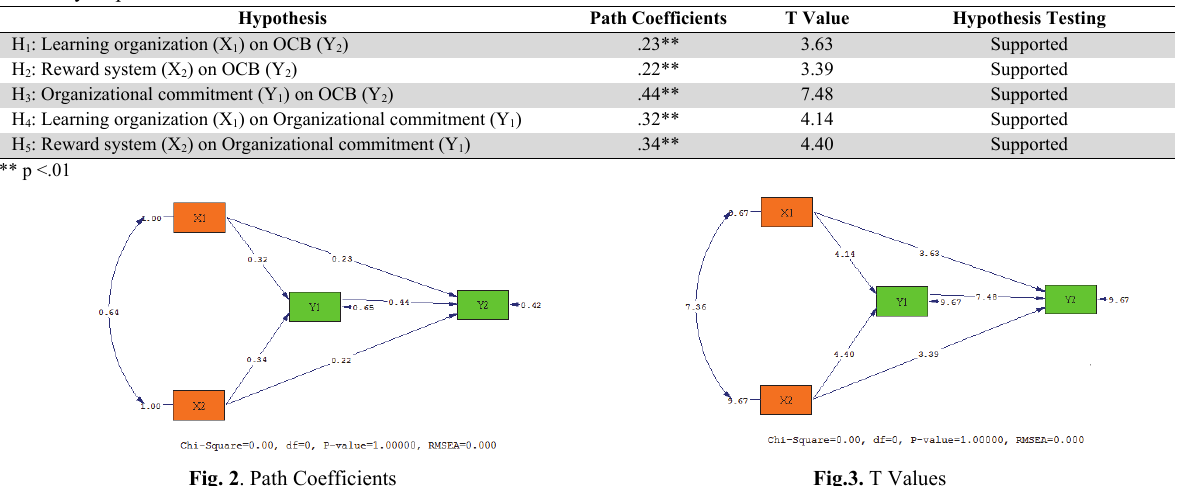
Summary of path coefficients and t